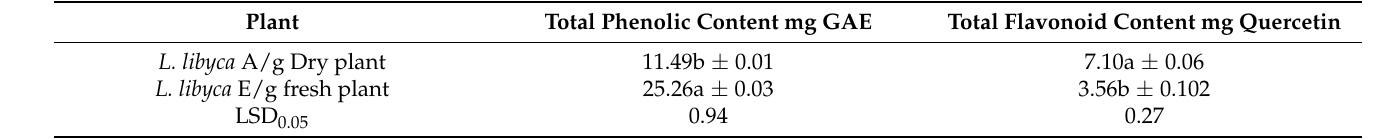
Table 4. Comparison of total phenolic and flavonoid contents of L. libyca from Algeria ( L. libyca A) and L. libyca Egyptian ( L. libyca E) (methanol